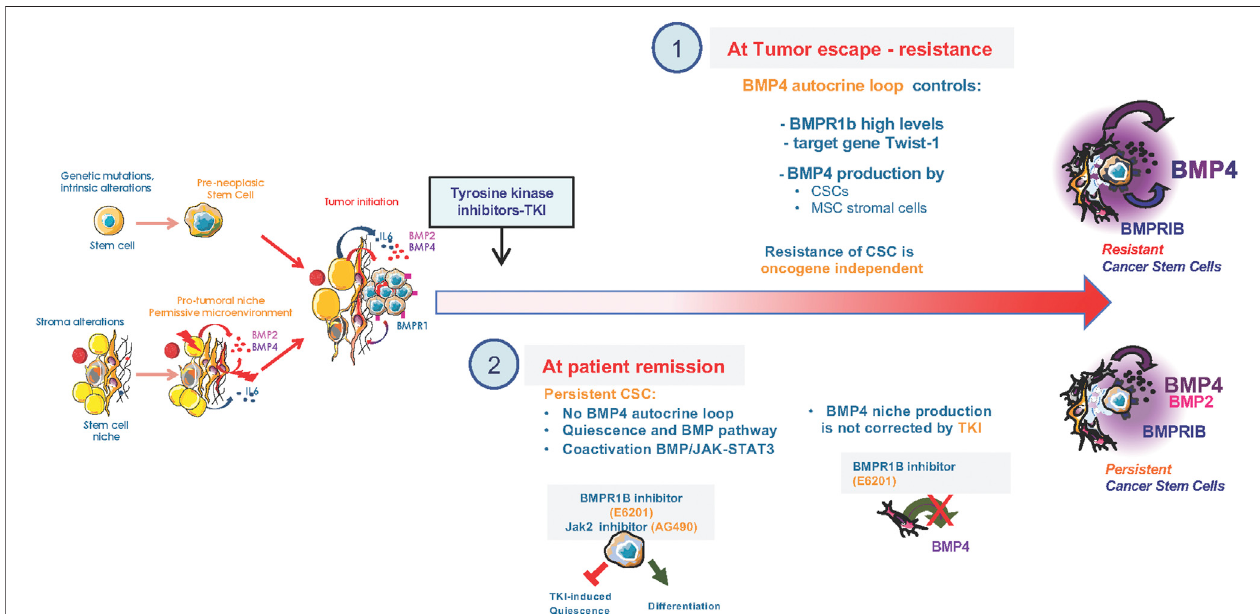
FIGURE 2 | Alterations of the BMP pathway upon treatment of CML cancer stem cells. (1) Setting of a BMP4 autocrine loop in CSCs that controls Twist1 expression topromoteresistanceofCMLCSCstotyrosinekinaseinhibitors(TKIs)andretainedhighproductionofBMP4bybonemarrow mesenchymalstromalcellsof resistantpatients. (2) AtpatientsremissionunderTKItreatment,CSCsshowedaco-enrichmentinBMPandJak2-signaling,quiescenceandSCsignatures,asidenti fi ed bysinglecellRNA-SeqanalysisofTKI-persistingcells.InpersistingCSCs,BMPR1b-cellsdisplayedco-activatedSmad1/5/8andStat3pathwaysthataretargeted byblockingBMPR1B/Jak2signalusing,forexample,aspeci fi cBMPR1binhibitor(E6201)orJak2(AG490)inhibitor.TheTKI-inducedquiescenceofresidualCSCsrelies on a BMP4 signal delivered by surrounding mesenchymal cells and inhibited by the BMPR1B inhibitor (E6201). Dual targeting of BMP and Jak2 ef fi ciently reverses TKI- dependent induction of quiescence and allowed re-entry into a differentiation process of the BMPR1b + CSC sub-fraction that was adherent to the stroma.